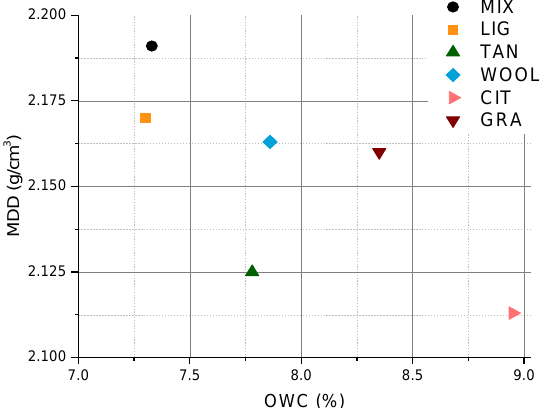
Figure 4. Optimum water content (OWC) versus the maximum dry density (MMD).